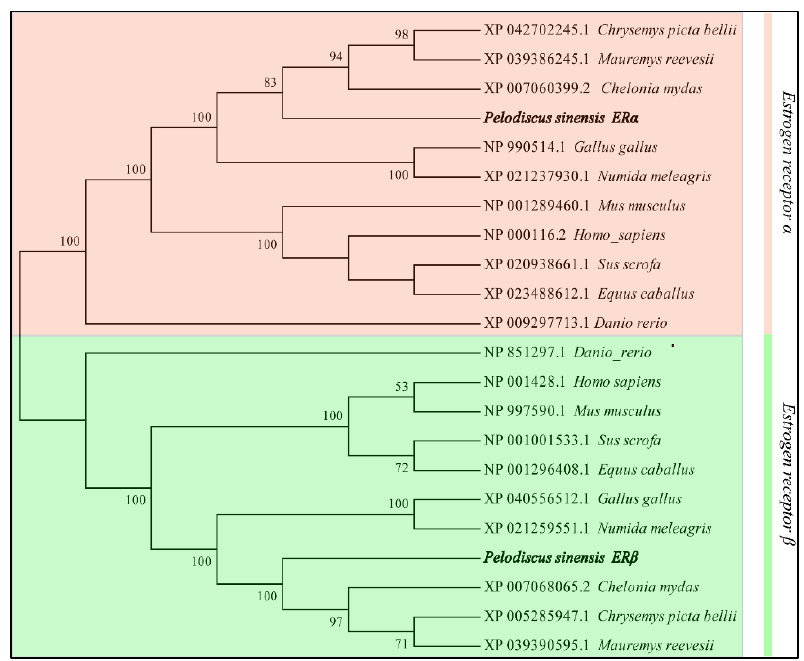
Figure 2. Gene tree of ER amino acid